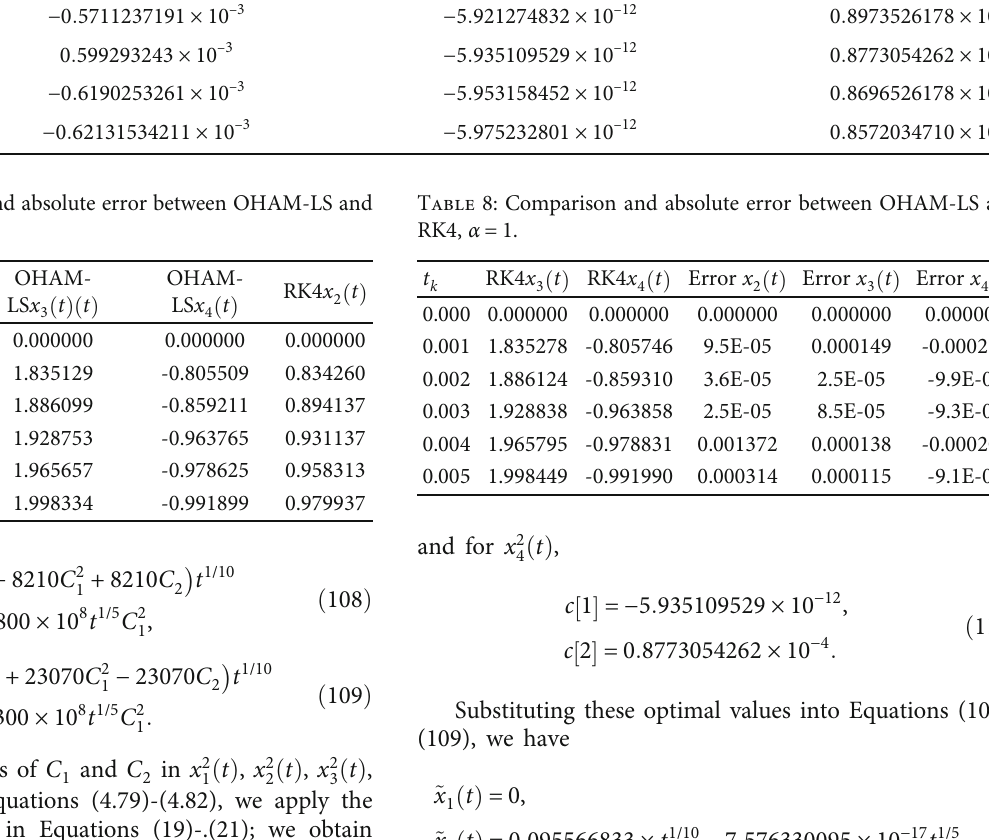
Table 6: Control-convergence parameters C